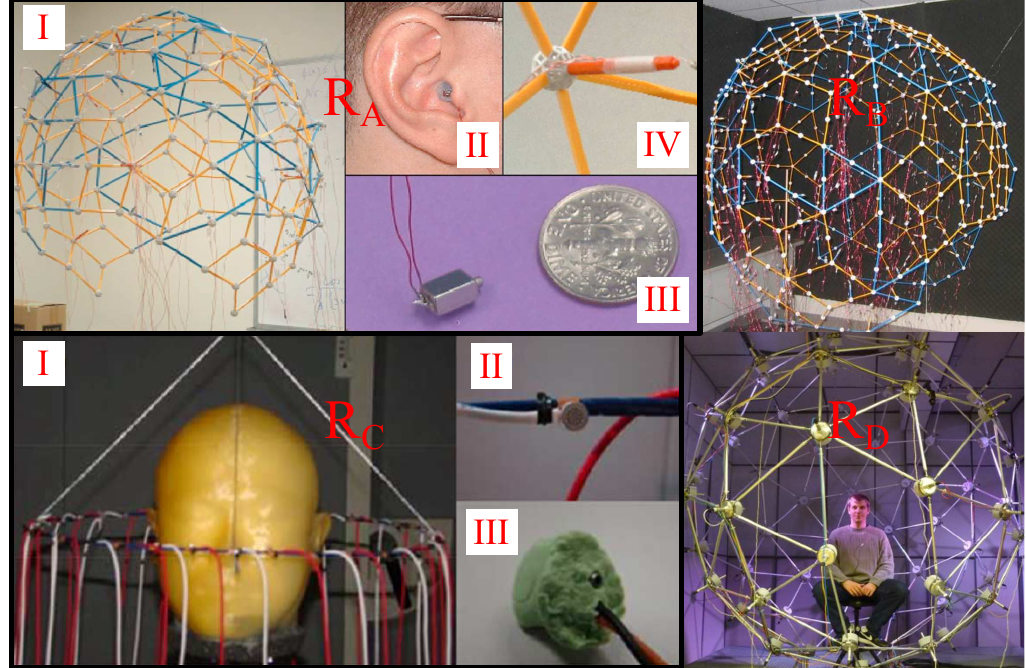
Figure 10. Examples of system setups based on the reciprocity theory [57,143–145] (all pictures are taken from available publications, some of them are partly cropped to fit into the overall